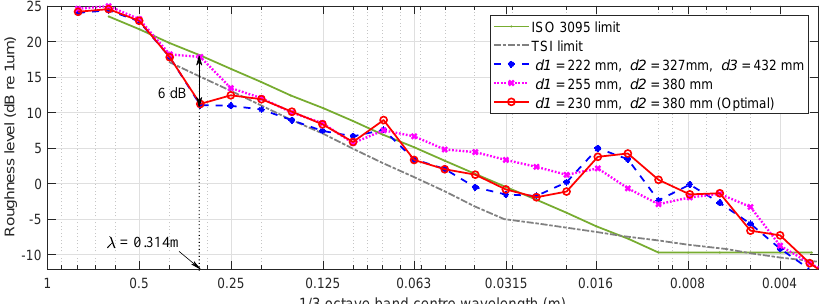
Figure 12. Spectral analysis of measured roughness on the field track